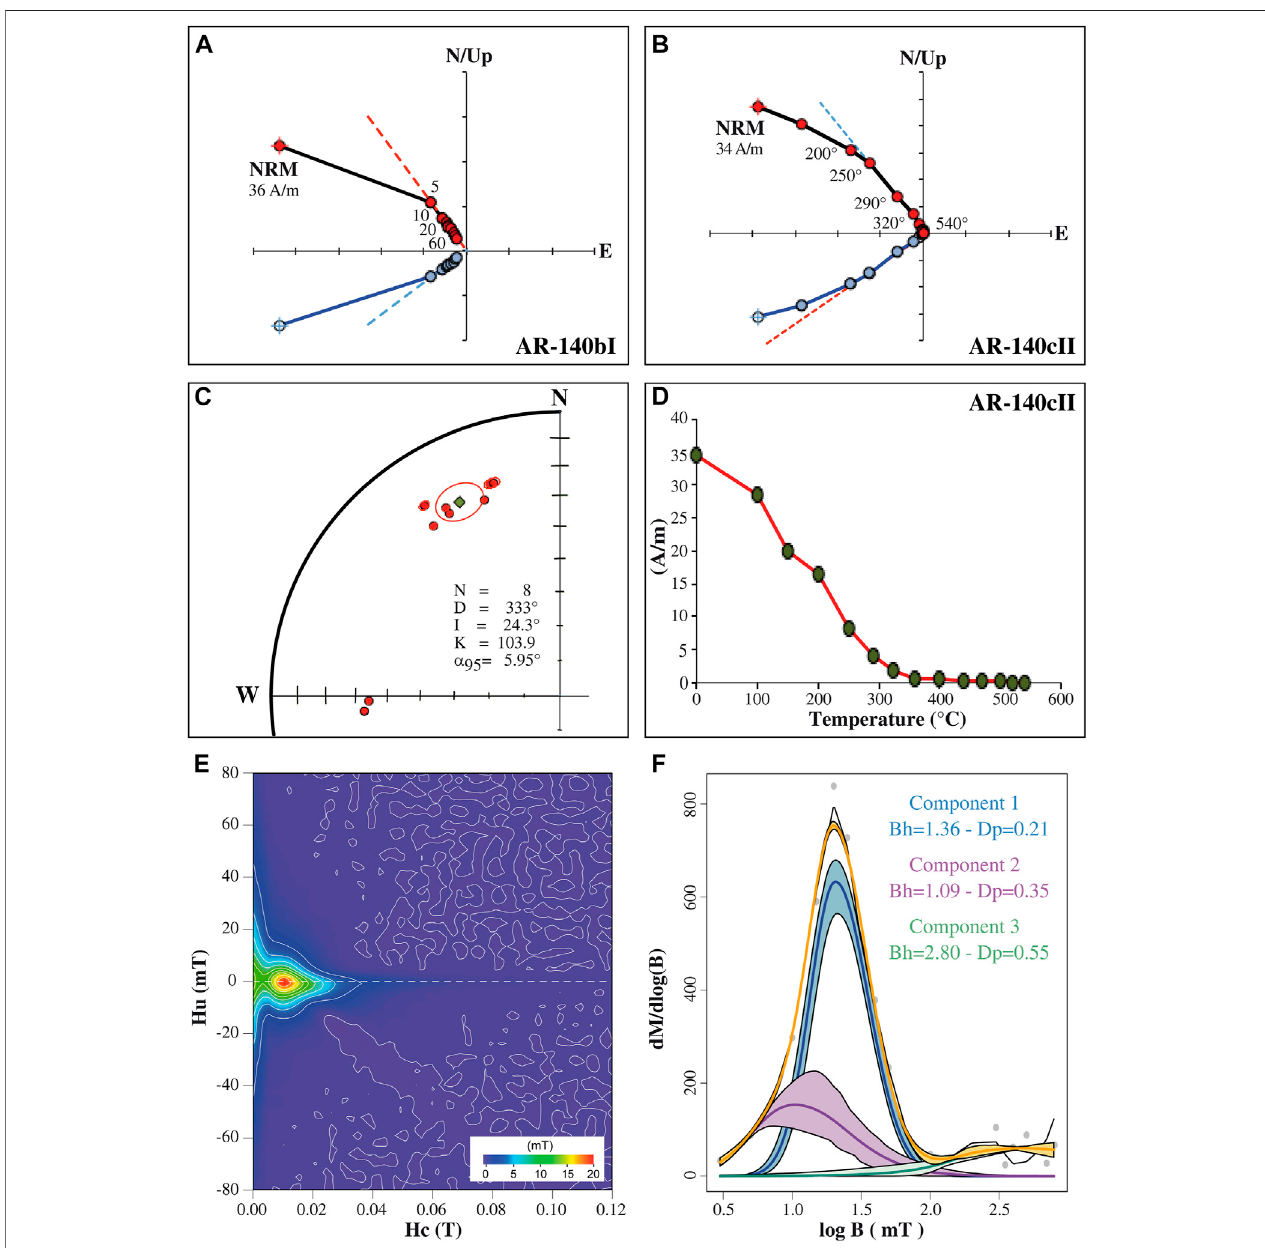
FIGURE 8 | Rock magnetism results of the volcanic pipe at the UH-10 site. Zijderveld plot of AF (A) and thermal (B) demagnetization. (C) stereonet of the paleomagnetic results with mean values and statistical parameters calculated by excluding the two samples with a western declination. (D) magnetization decay during the thermal experiment. (E) FORC diagram indicating the presence of two components with different grain size. (F) coercivity distribution from IRM acquisition with shaded areas representing the 95% con fi dence interval.